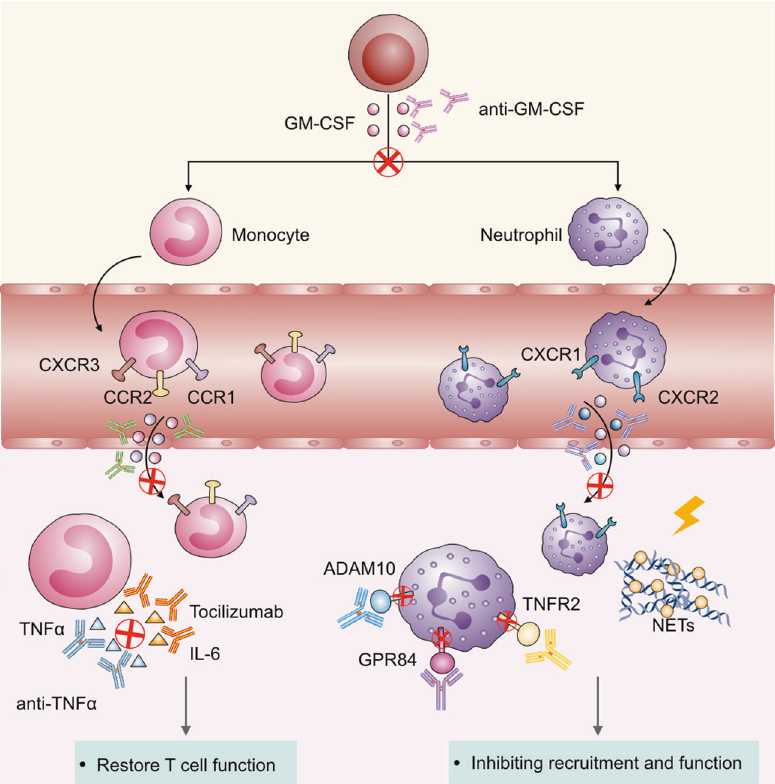
Fig. 3 Therapeutic strategies targeting myeloid cells in COVID-19. Targeting GM-CSF blocks the differentiation of myeloid cells into neutrophils. Using chemokine antibodies could block the recruitment of monocytes and neutrophils into the infected tissue. Treatment with tocilizumab and anti-TNF- α , which blocks IL-6 and TNF- α secretion by monocytes, can restore T-cell function. Antibodies targeting checkpoints such as ADAM10, GPR84, and TNFR2, which are highly expressed on neutrophils, can inhibit the function of neutrophils. Targeting NETs is a therapeutic intervention for neutrophils in